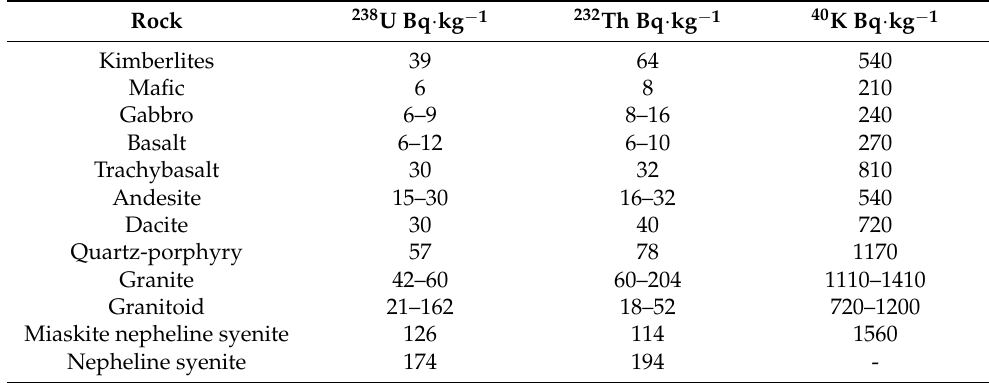
Table 1. Radioactivity of 238 U, 232 Th and 40 K in different type of rocks [12,20–24].